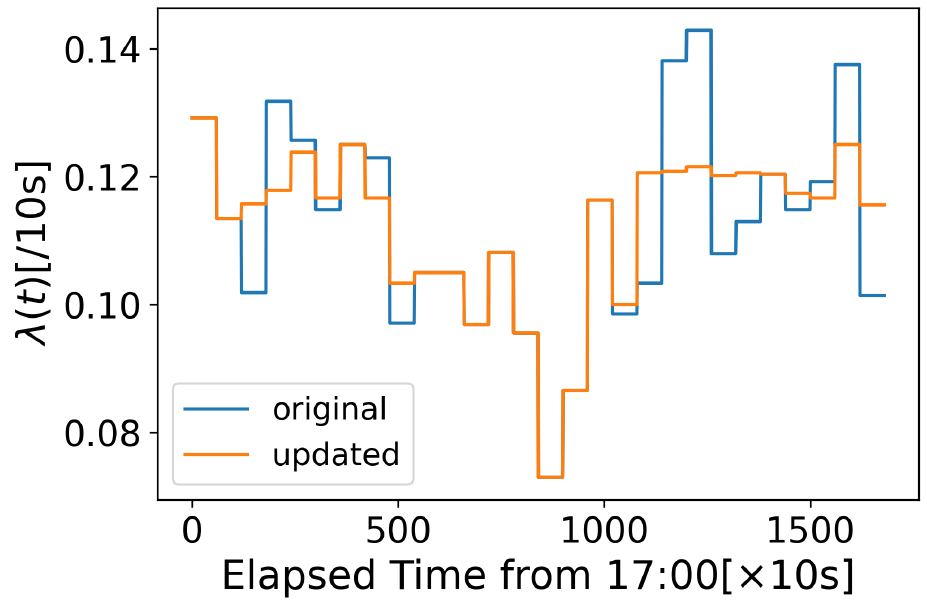
Figure 10. Original Scenario 0 and updated Scenario